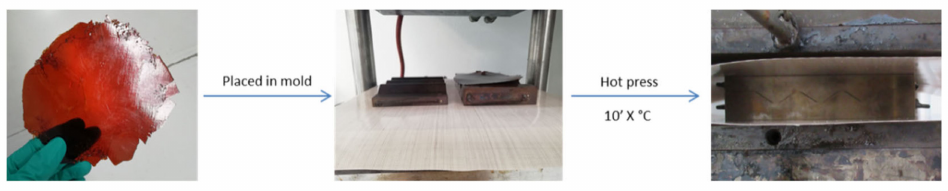
Figure 4. Procedure for reprocessing the prepared materials.